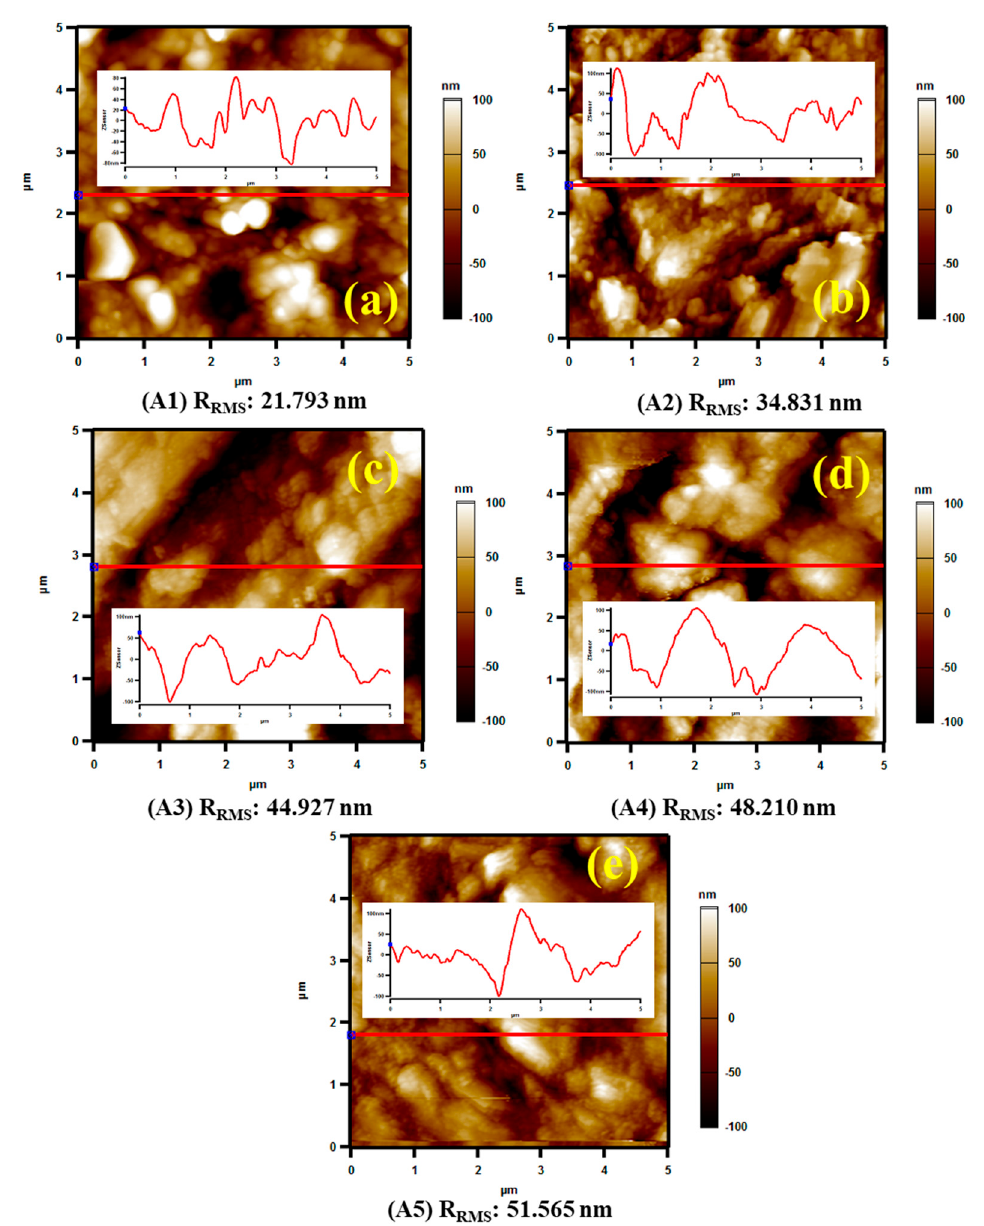
Figure 5. The 2D and X-profile of atomic force microscope (AFM) images of ( a ) pure Al, ( b ) Al-5SiC, ( c ) Al-5SiC-3ZrO 2 , ( d ) Al-5SiC-6ZrO 2 , and ( e ) Al-5SiC-9ZrO 2 nanocomposites.